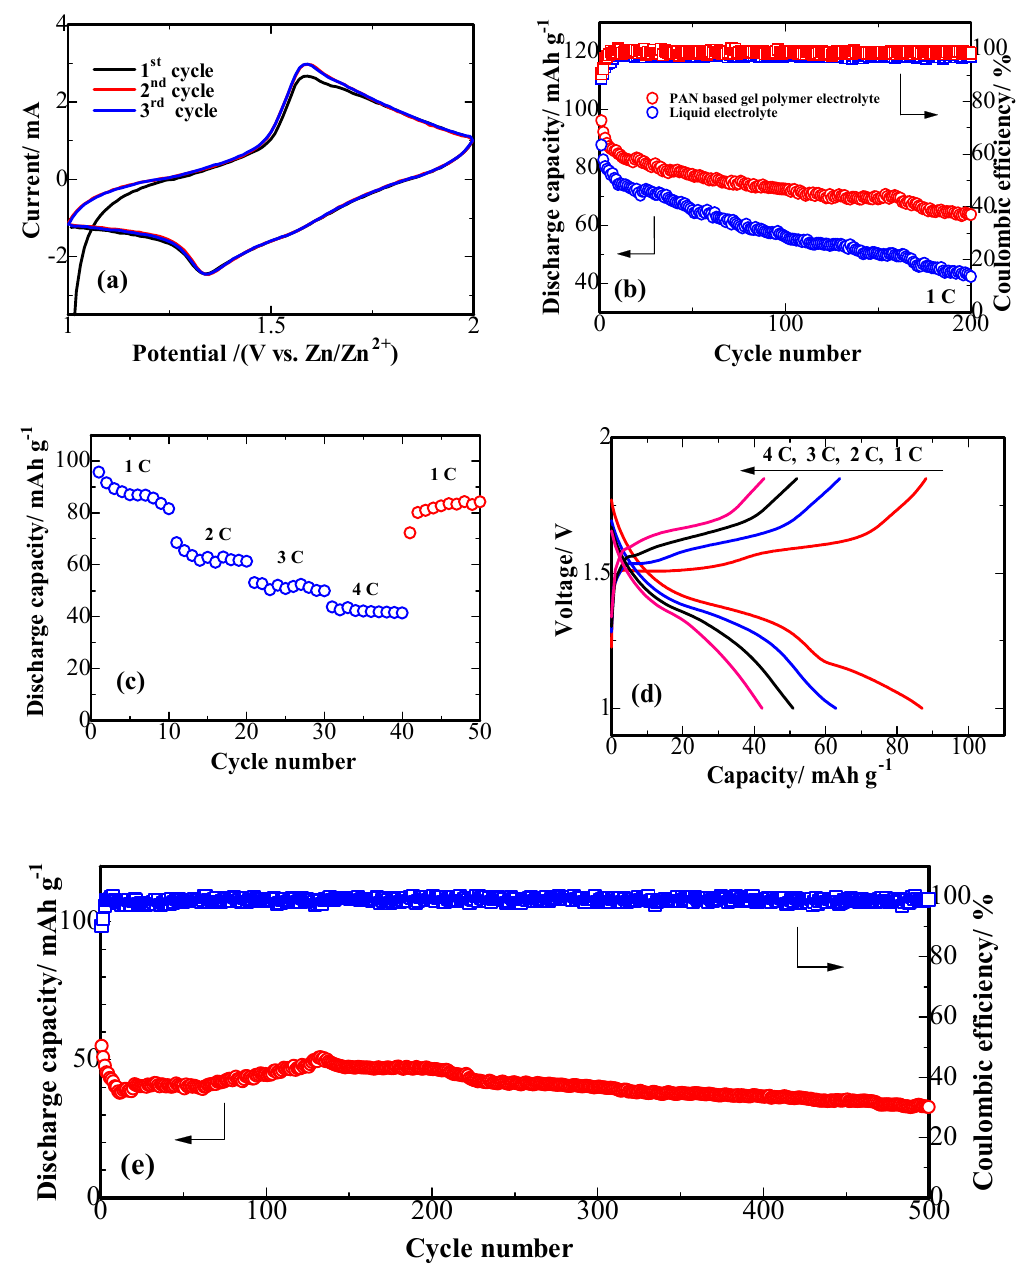
Figure 8. Electrochemical performance of a cell with the PAN-nanofiber-based gel polymer electrolyte of Na 4 Mn 9 O 18 electrode (vs. Zn/Zn 2+ ) ( a ) CV curves at a rate of 0.1 mV s − 1 ; ( b ) Cycling performance of liquid electrolyte cell (the blue) and the PAN-nanofiber-based gel polymer electrolyte cell (the red); ( c ) Rate capability and ( d ) Charge/discharge profiles at various rates; ( e ) Prolonged cycling performance of the PAN-nanofiber-based gel polymer electrolyte cell at 4 C.